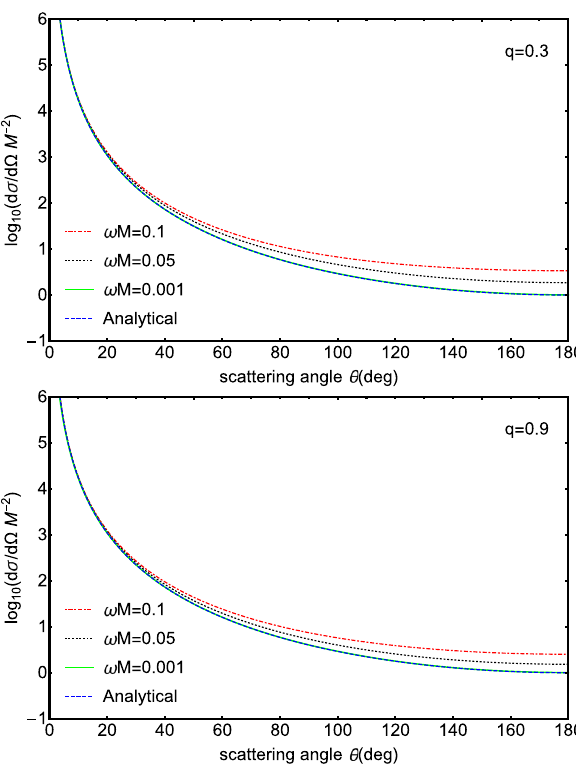
Fig. 7 The low frequency behavior of the scattering cross section for q = 0 . 3 (top) and 0.9 (bottom). The solid green lines are given by the analytic formula (26). This figure shows that in the low frequency limit ω M → 0, the scattering cross section of the GMGHS black hole is independent on q